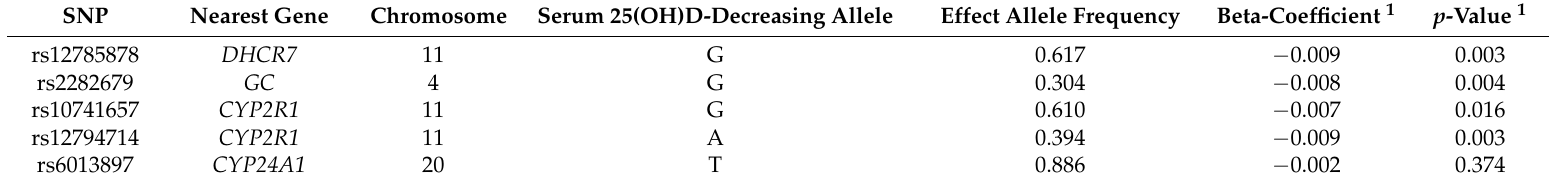
Table 1. Association between five single-nucleotide polymorphisms (SNPs) and 25(OH)D status.